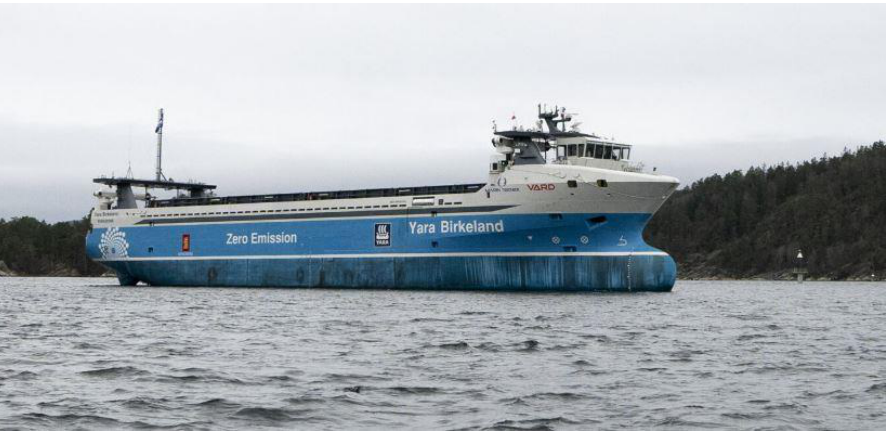
Figure 14. Yara Birkeland, the first fully electric and autonomous container ship [72].